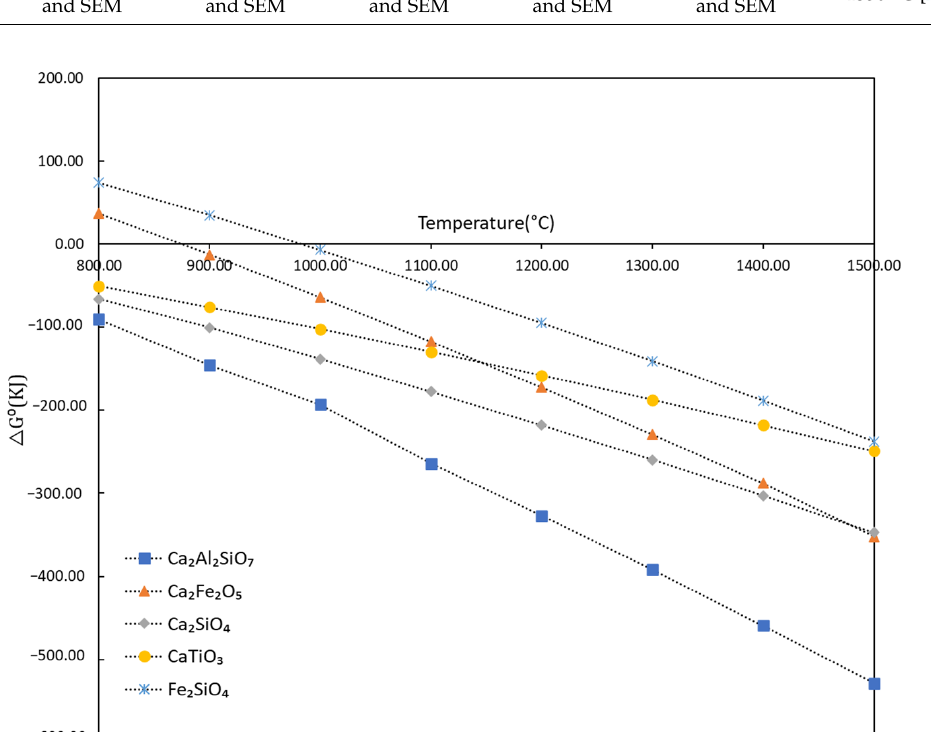
Figure 12. Standard free energy of formation, △ G° (J/mol at 1 atm), for one mole of different phases at elevated temperatures. Calculated using Factsage 8.1 software.